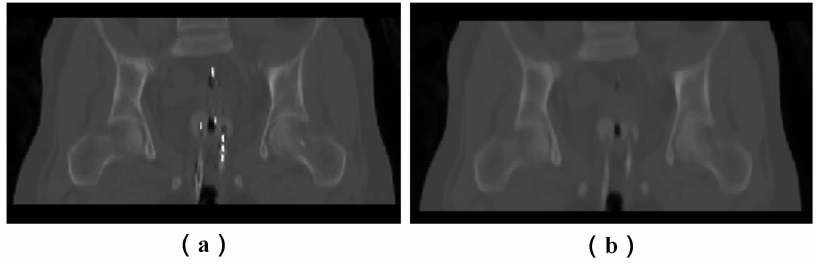
Fig 4. Denoising of HDR-BT images by median filter. (a) HDR-BT image with unevenbright voxels before denoising. (b) HDR-BT image after